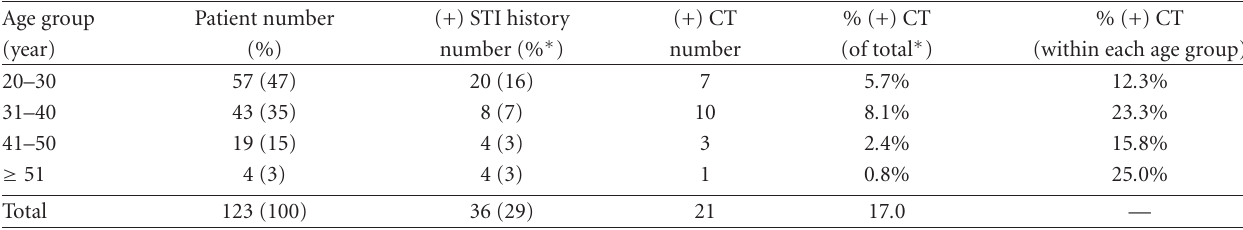
Table 2: Frequency of C. trachomatis infection among women with cervicitis according to their age groups. (CT = C. trachomatis ; STI = sexually transmitted